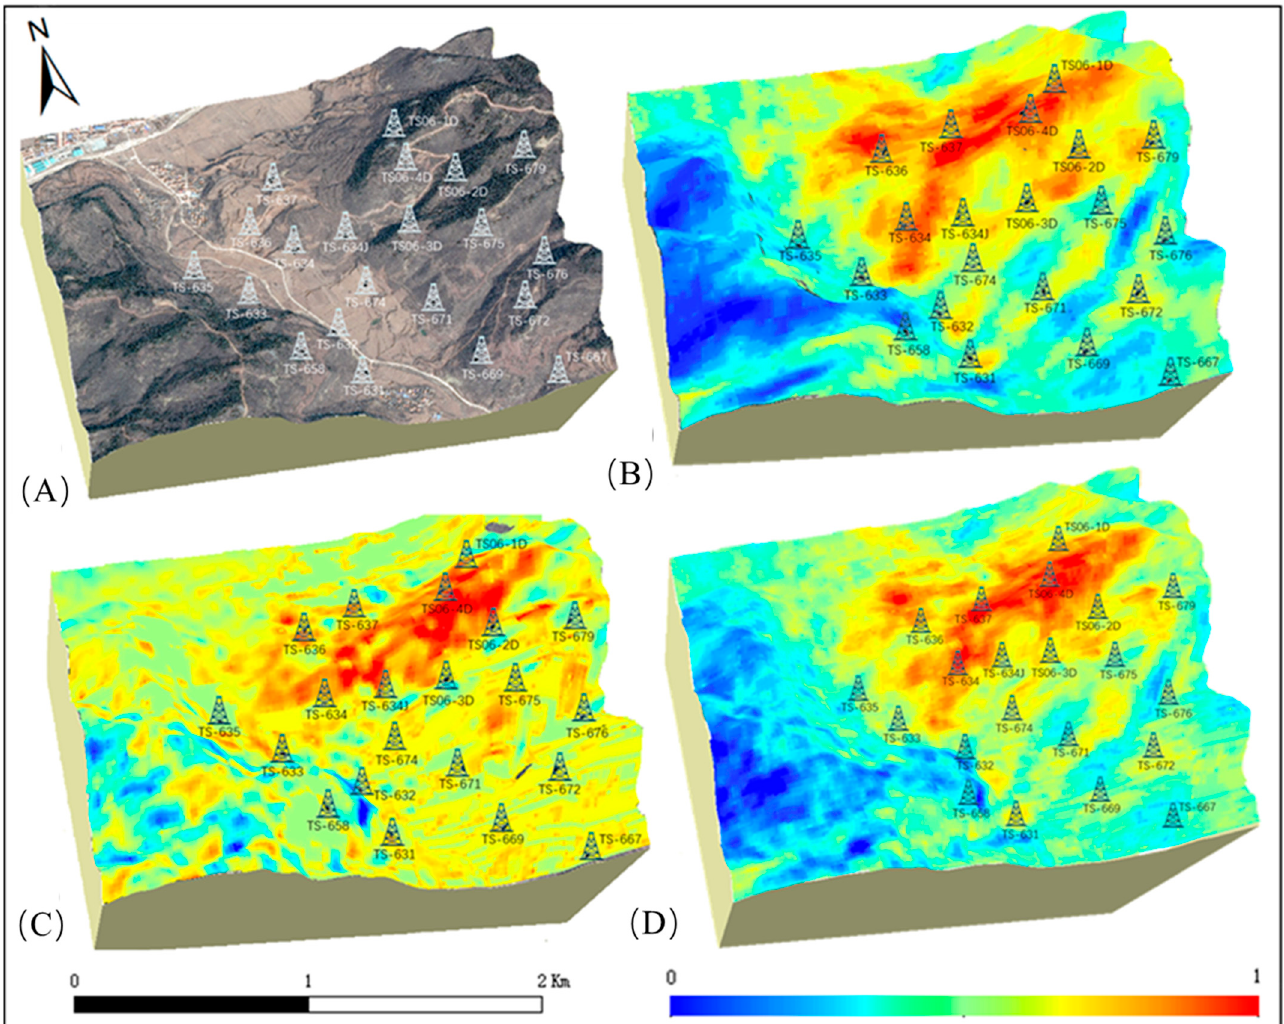
Figure 10. ( A ) UAV 3D model with well distribution, ( B ) UAV 3D model with microseismic monitoring results, ( C ) UAV 3D model with InSAR monitoring results and ( D ) UAV 3D model with monitoring results superposition.